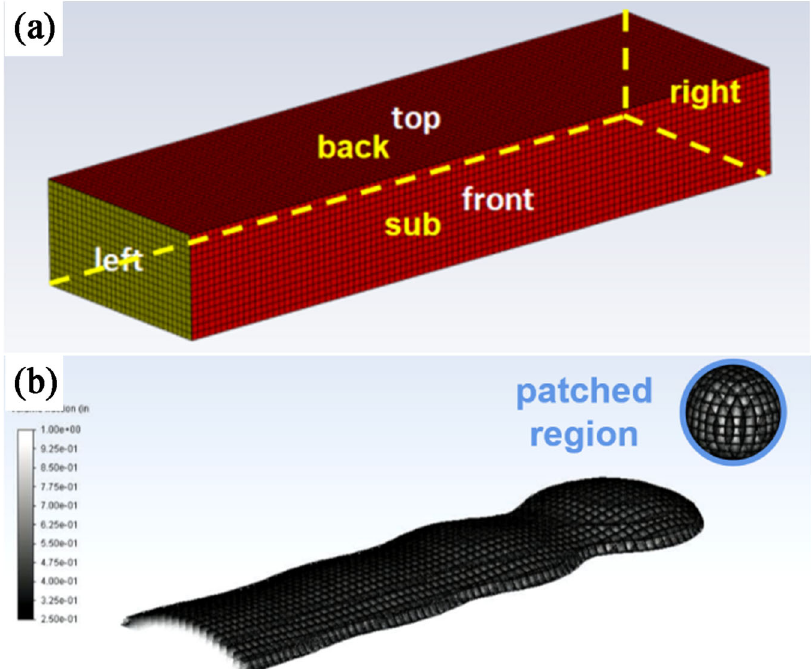
Fig. 1 Overview of the model. a Geometry of computational domain and meshes. b Deposited droplets and de fi nition of the spherical droplet. a Is an overview of the computational domain and meshes drawn from ICEM, it is a cuboid divided by hexahedral meshes, and every mesh has dimensions on the 1µm× 1µm×1 µm scale. Every side of the cuboid is named respectively in order to be de fi ned as different types of boundaries in Fluent. b Is drawn from Fluent, which shows the deposited droplets and newly de fi ned droplet region on air with an initial velocity.